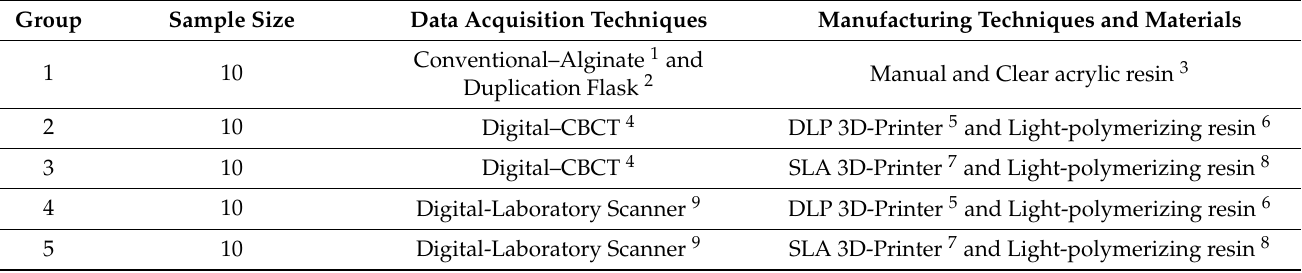
Table 1. Characteristics of the research